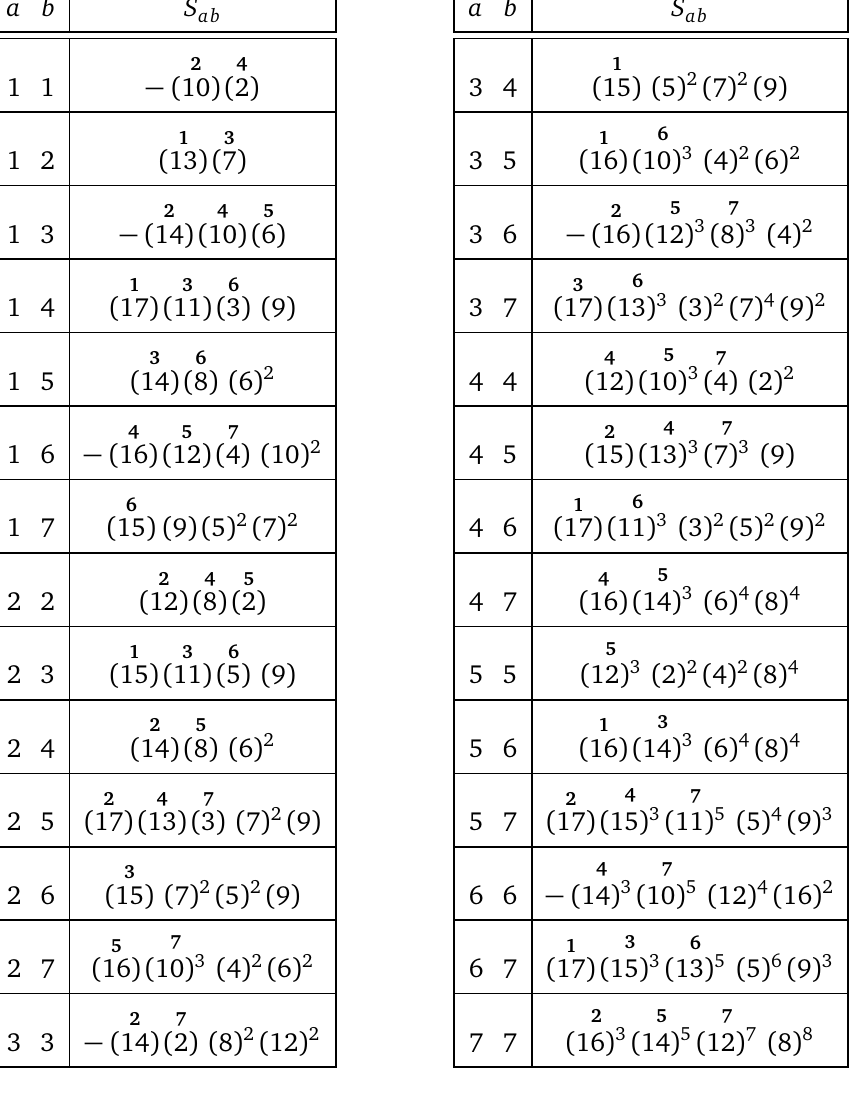
factorised scattering 7